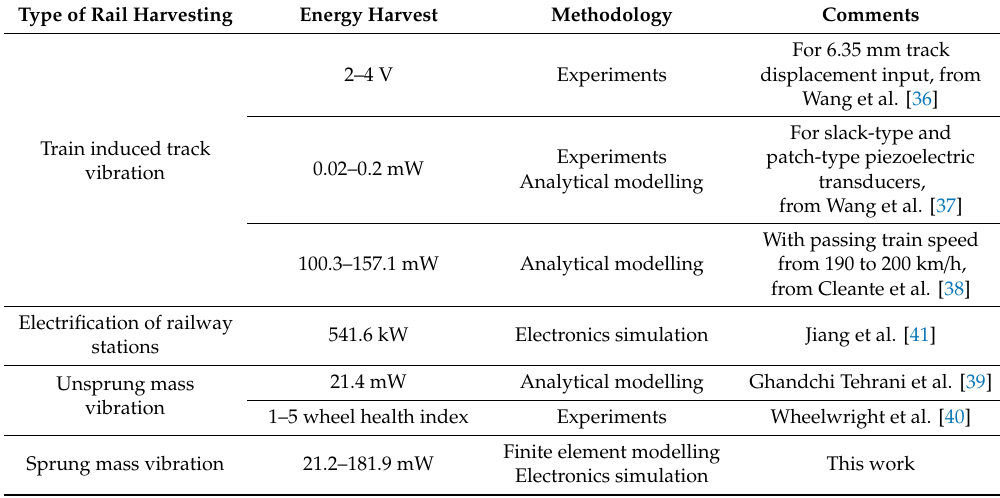
Table 8. Di ff erent types of energy harvested in the rail from the